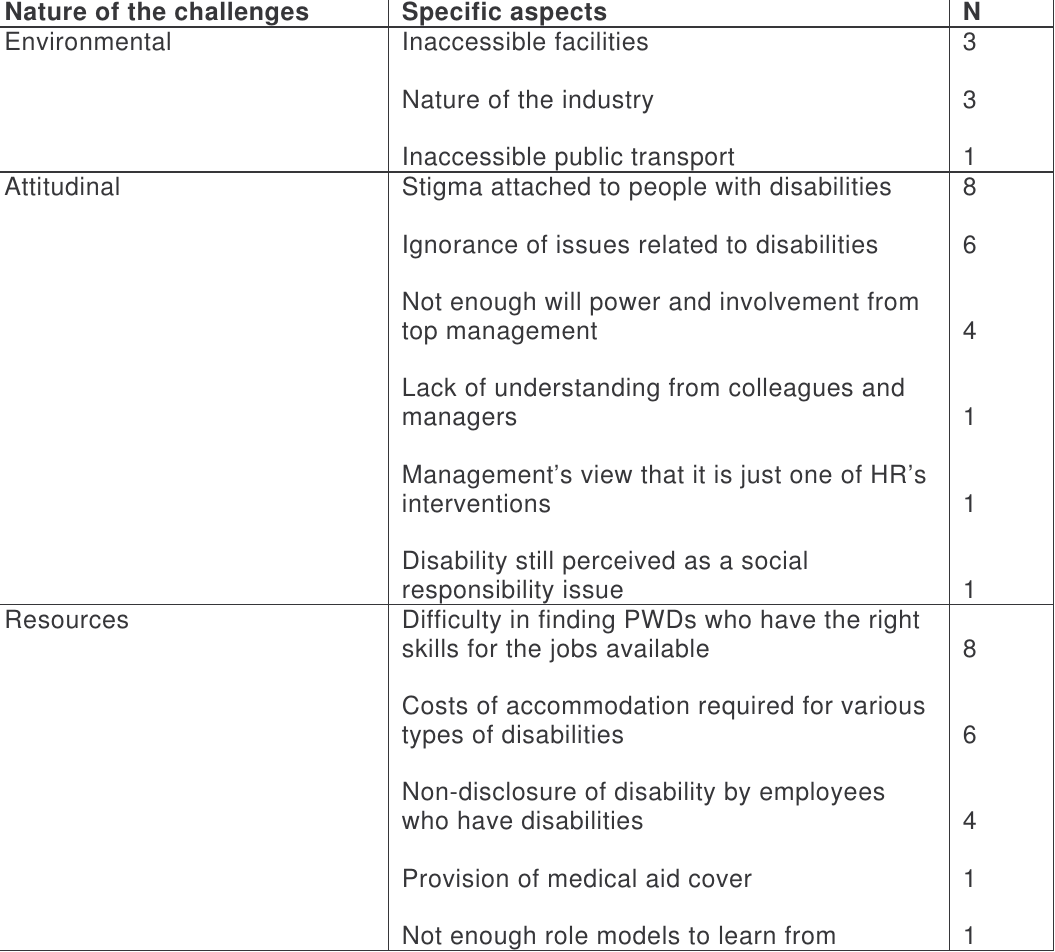
Table 10: Challenges associated with employing people with disabilities Nature of the